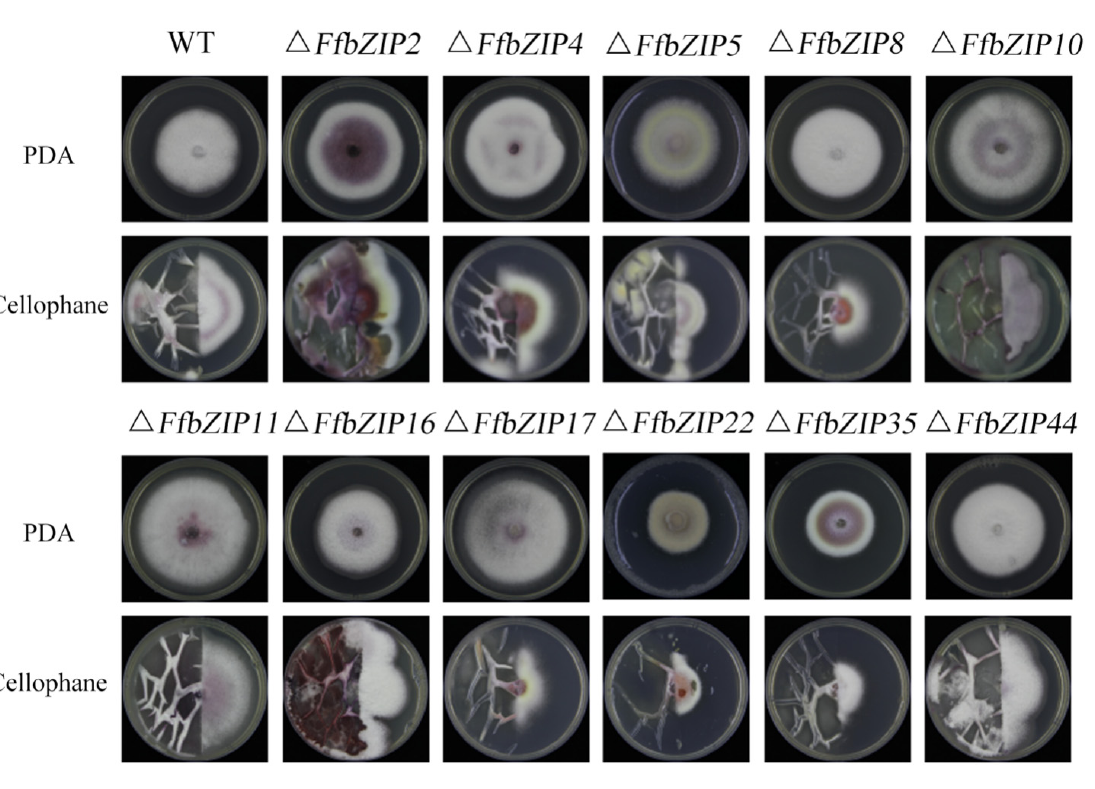
Figure 9. Determination of cellophane penetration ability of wild type and FfbZIP knockout mutants.